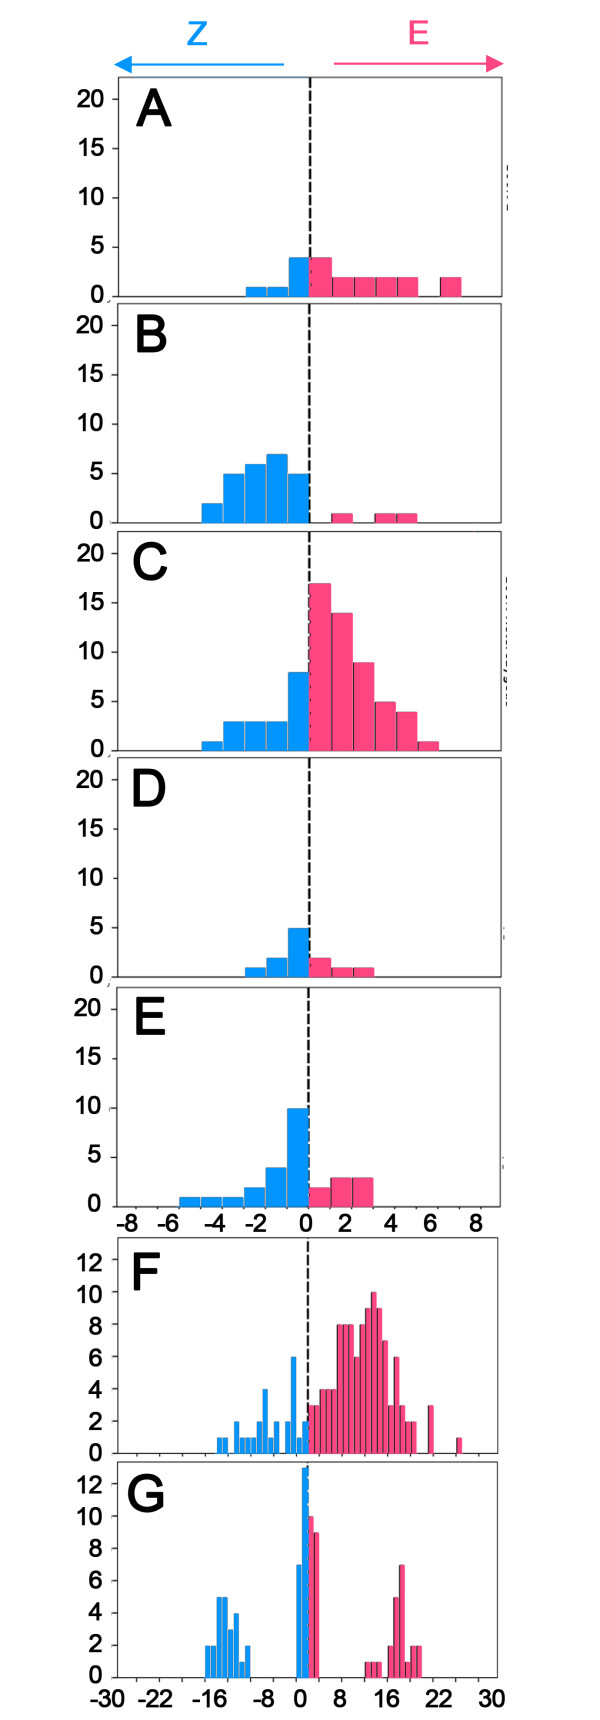
Average amplitude ratio histograms for O. nubilalis populations. Frequency distributions of average sensillum amplitude ratios combined from crosses shown in Figure 2. Each histogram depicts the sum of all individuals expected to carry specific genotypes according to the sex-linked hypothesis (see Figure 2 for separate populations): A) XEXE B) XZXZ C) XEXZ D) XEXE + XEXZ and E) XZXZ + XEXZ. Bottom figures show previously published data from F) Cossé et al., 1995 [13] and G) Hansson et al., 1987 [11]. Note the different x-axis scale in histograms F) and G).